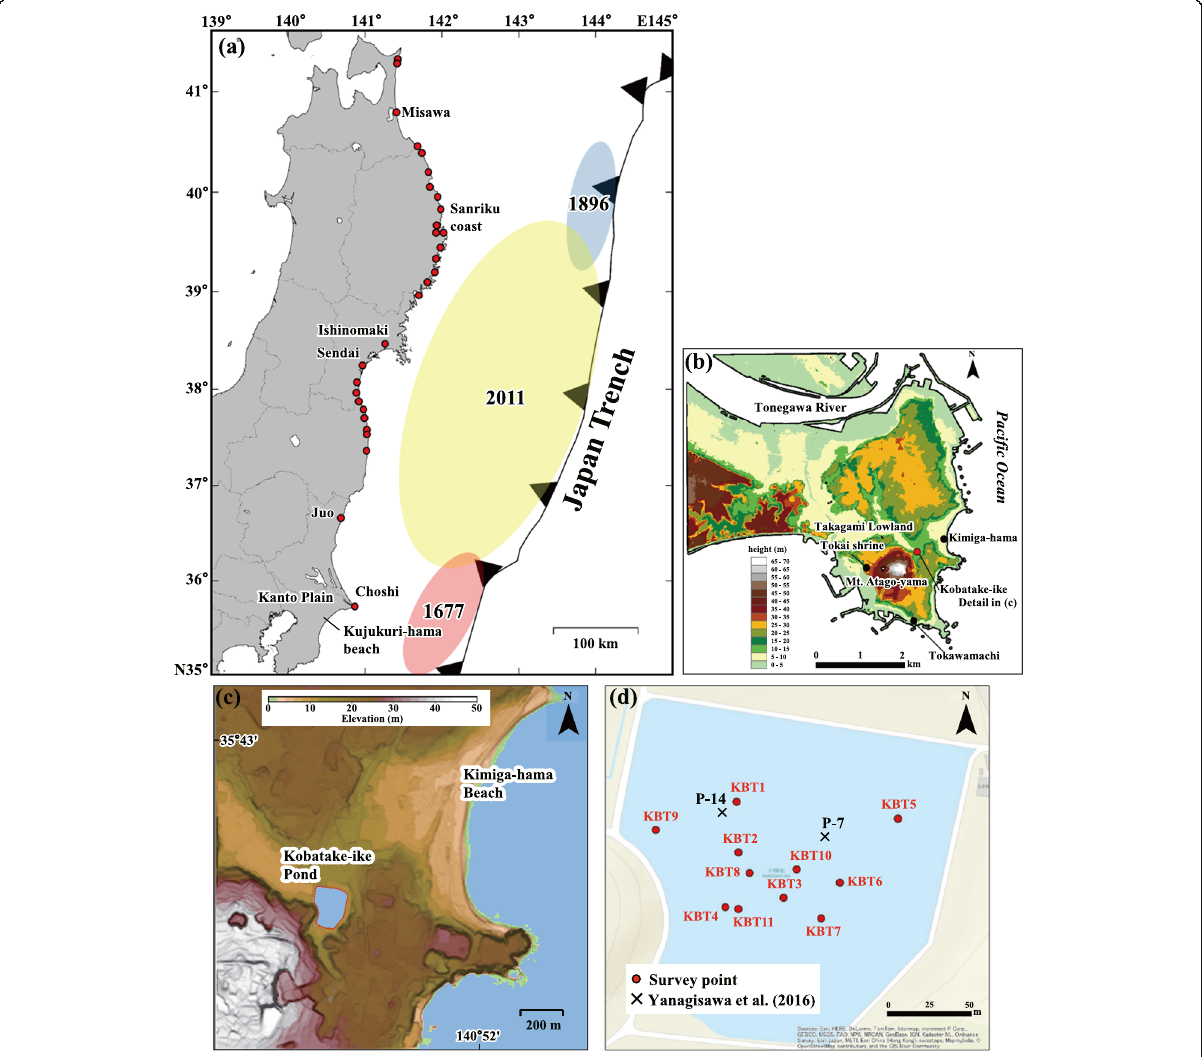
Fig. 1 a Map of Tohoku and Kanto regions showing the location of Choshi City and known paleo-tsunami deposits (red circles) identified by earlier studies. b Digital elevation model showing the topography around the Kobatake-ike pond (data from the Geospatial Information Authority of Japan). c Detailed digital elevation model showing the topography from the Kimiga-hama beach to the Kobatake-ike pond (same data to ( b )). d Survey points (red circles) in the Kobatake-ike pond. KBT1 to KBT11 are core numbers in this study. A black cross mark shows the location of the P-7 and P-14 cores sampled by Yanagisawa et al. (2016). Generated by ArcGIS (Environmental Systems Research Institute,